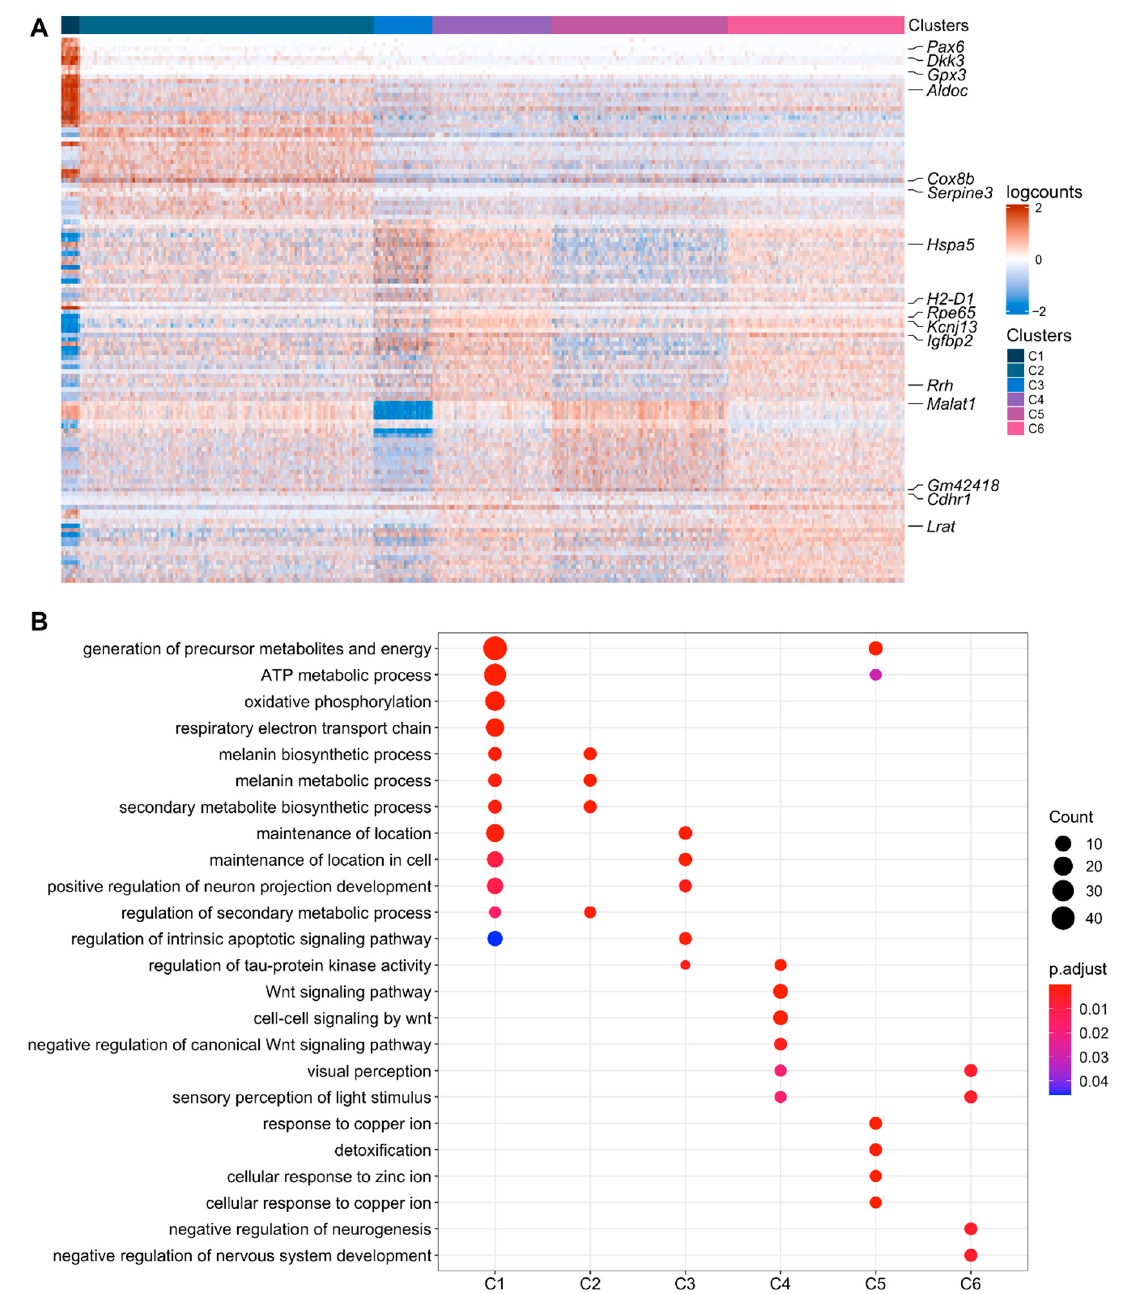
Figure 3. Differential expression analysis of RPE cell clusters in R1. ( A ) The top 20 differentially expressed genes in clusters, ranked by the false discovery rate (FDR), are shown in the heatmap. Gene expression values were centered, scaled, and transformed to a scale from − 2 to 2. Select signature genes are highlighted on the right. ( B ) Enrichment of biological processes in differentially upregulated genes in each cluster using clusterprofiler. The significance threshold for all enrichment analyses was set to 0.05 using Benjamini-Hochberg corrected p -values.